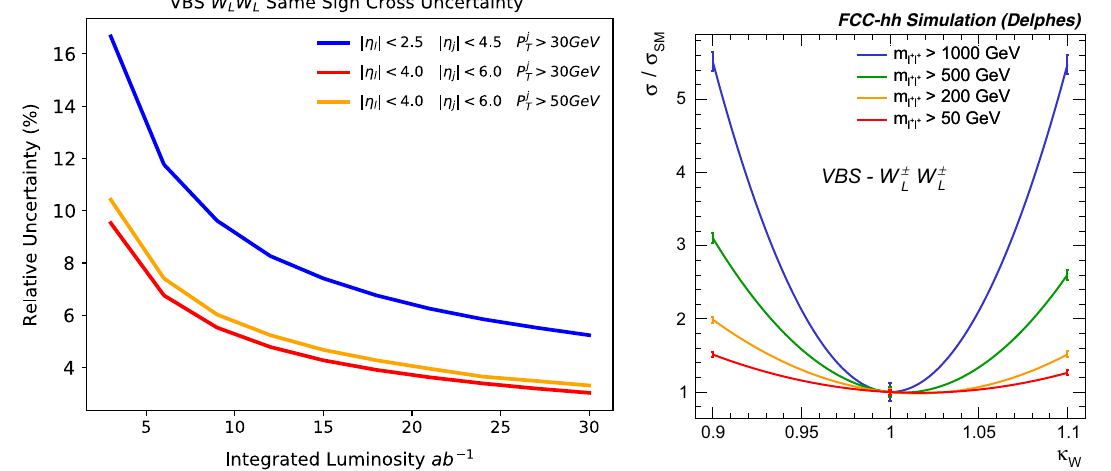
Fig. 4.9 Left: precision in the determination of the scattering of same- sign longitudinal W bosons, as function of luminosity, for various kinematic cuts. Right: sensitivity of the longitudinal boson scattering cross section w.r.t. deviations of the WWH coupling from its SM value